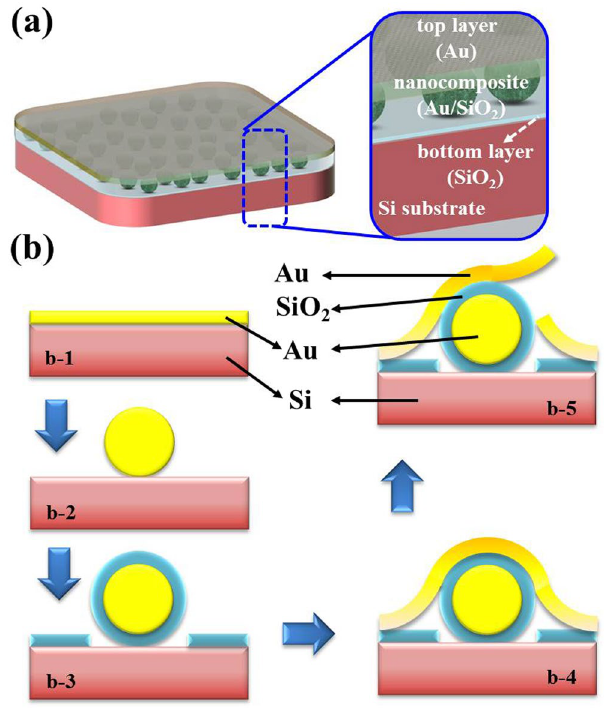
Figure 1. Schematic drawing of PMA and corresponding fabrication process. ( a ) The composition of PMA with pod-like nanostructures. The proposed pod-like nanostructures is composed of a SiO 2 layer on Si substrate, an optical nanocomposite (Au/SiO 2 ) layer and followed by a cover layer (Au) from bottom to the top. ( b ) Fabrication process of proposed